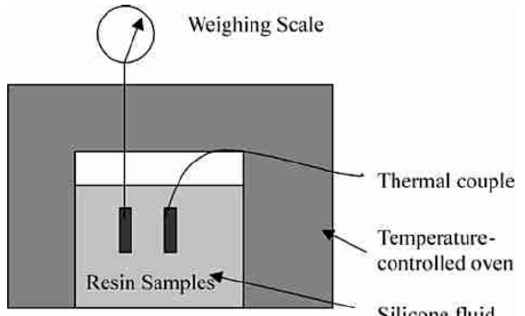
Figure 5. Schematic set-up for the in-situ measurement of curing shrinkage by buoyancy. Reprinted from reference [27] with permission from Elsevier.